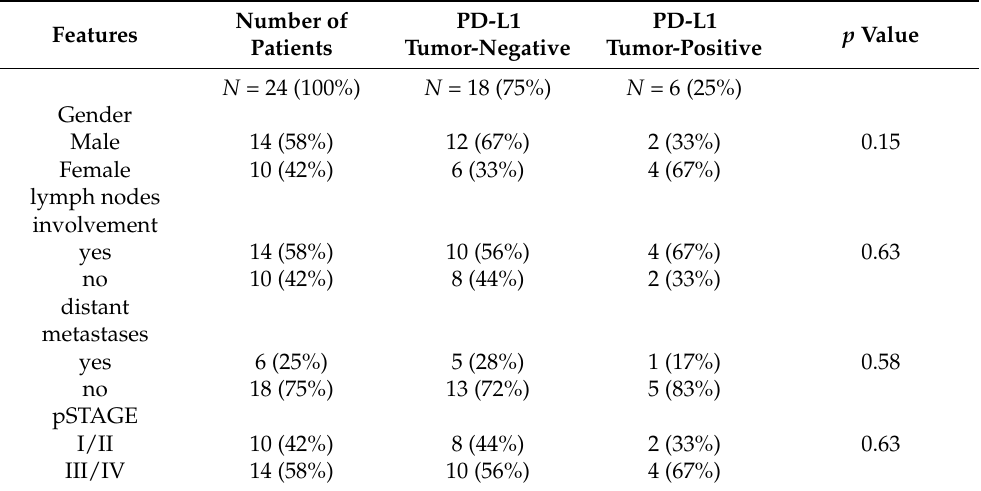
Table 11. Clinicopathological parameters of patients according to PD-L1 expression in the